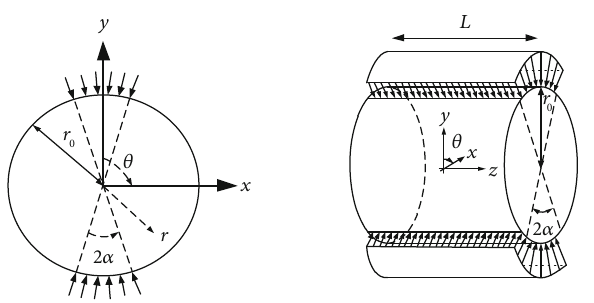
Figure 1: Three-dimensional mechanical model of Brazilian disc.